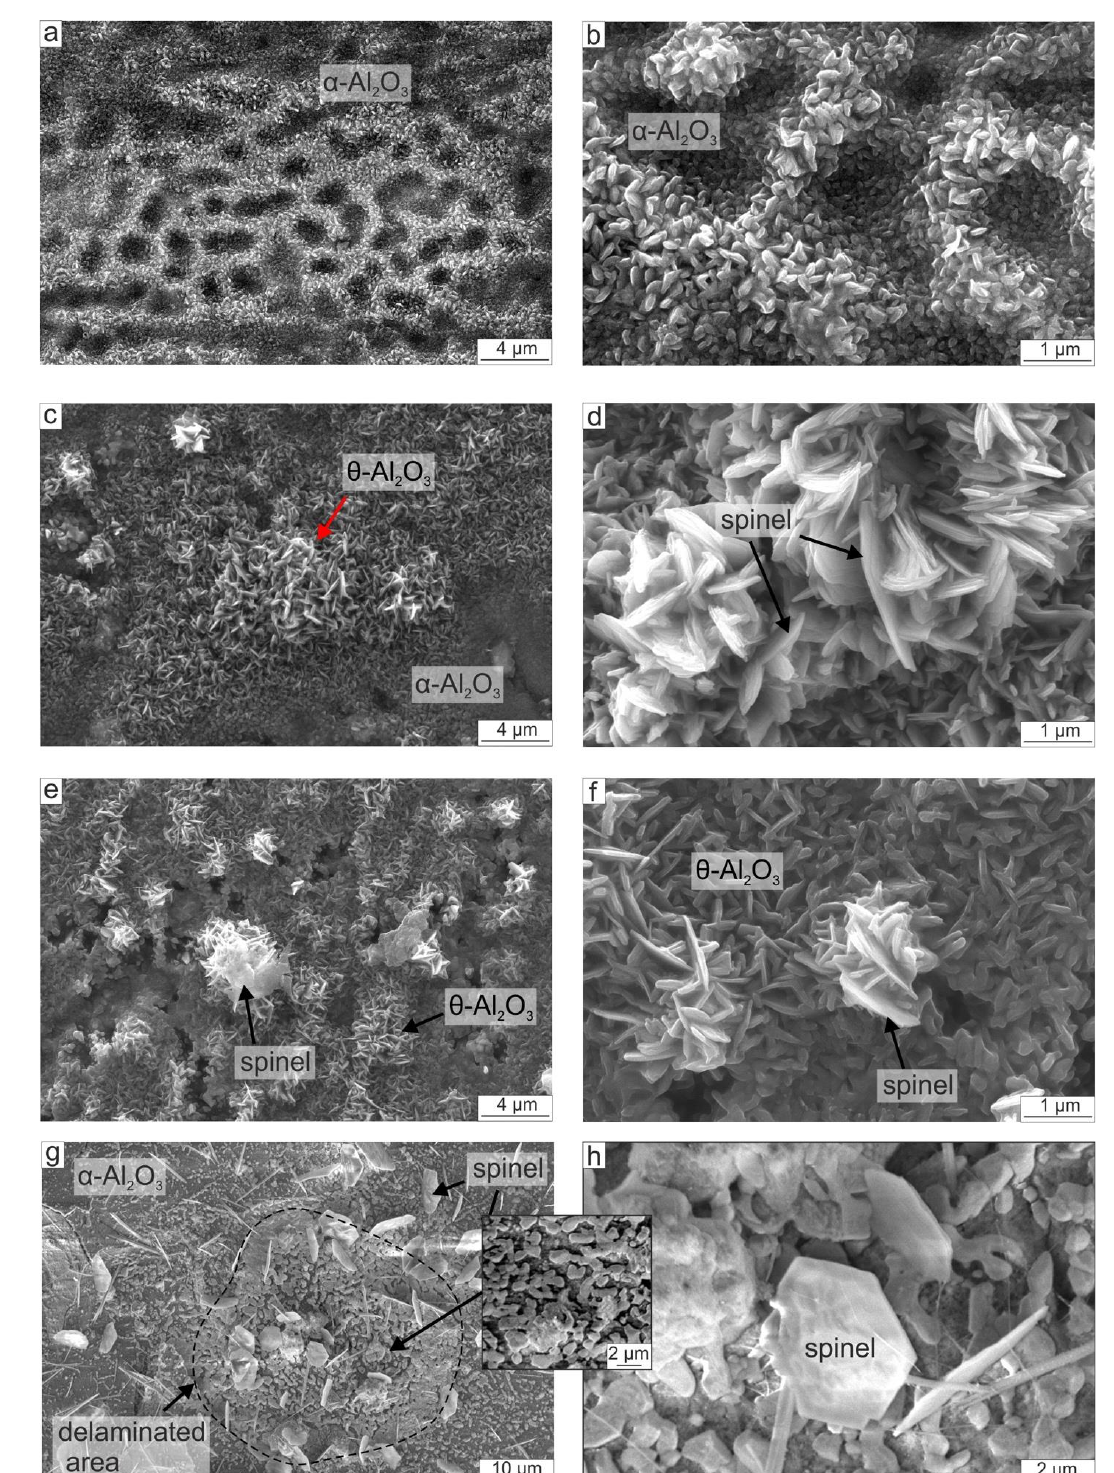
Figure 13. Morphology of the oxide films formed on NiAl-based coating after oxidation for 100 h at ( a , b ) 800; ( c , d ) 900; ( e – h ) 1000 °C.